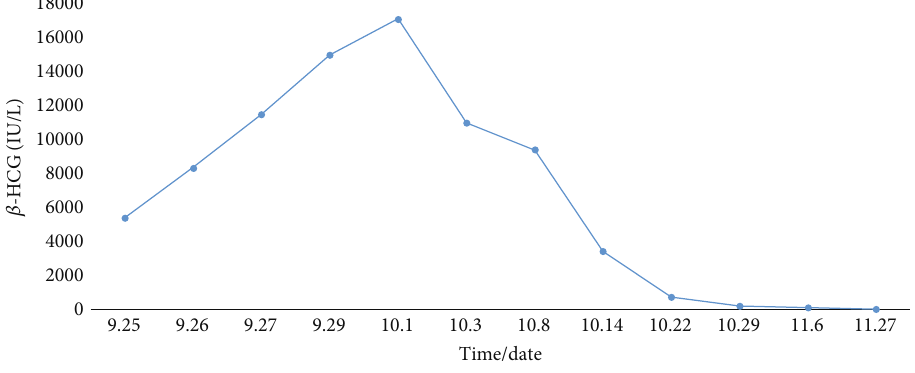
Figure 4: Changes in β -HCG levels during